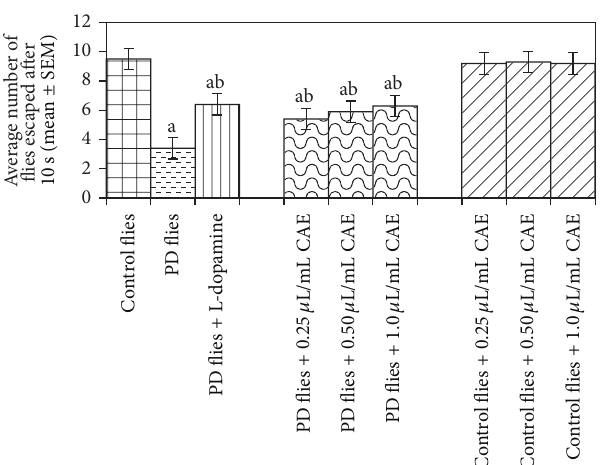
Figure 4: Effects of Centella asiatica extract (CAE) on the climbing ability. The flies were allowed feeding on the diet supplemented with Centella asiatica extract (CAE) for 24 days and then assayed for climbing ability. The values are the mean of five assays. ( a significant with respect tocontrol, 𝑃 -0.01; b significant with respect to PDmodel flies, 𝑃 -0.05). L-Dopa = 10 −3 M; control flies: UAS-alpha-syn; PD flies: elav-GAL4;